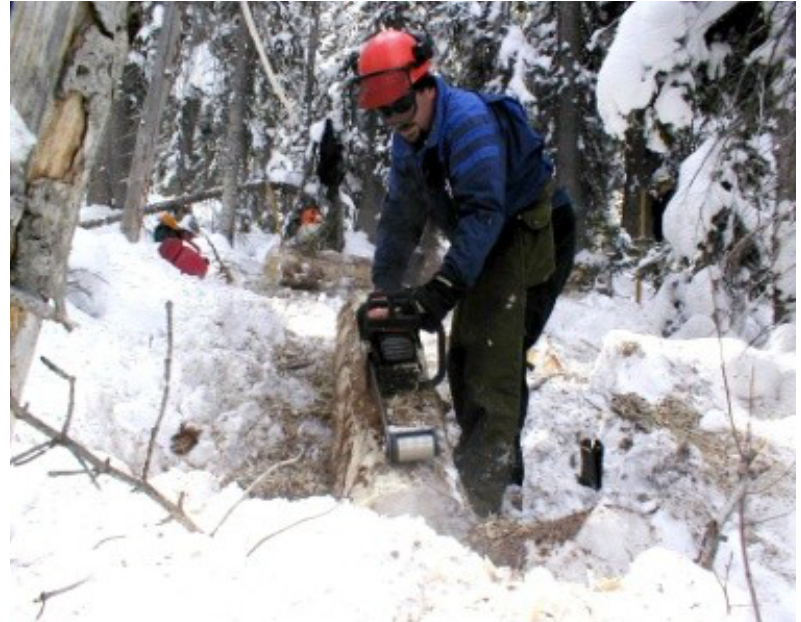
Figure 6. Log Wizard TM [211] used to peel bark from spruce beetle infested Engelmann spruce (Photo: A. Steven